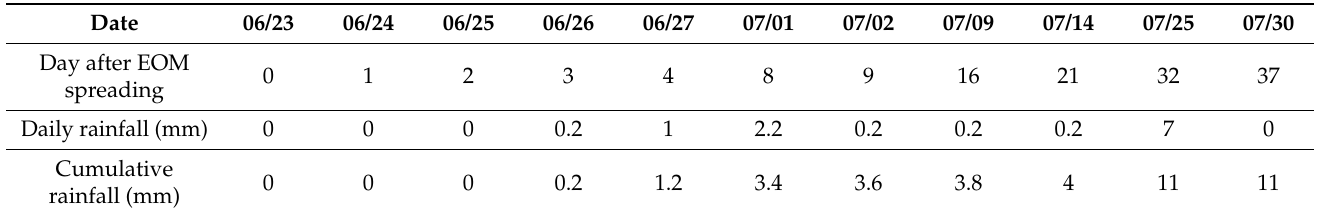
Table 4. Rainfall data during the field experiment (INRAE weather station,